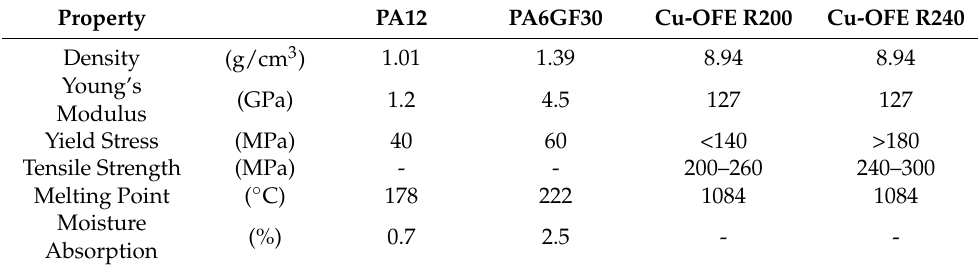
Table 1. Material properties of the investigated busbars extracted from data sheets for copper [21] and polyamide [22,23]. The properties of PA12 and PA6GF30 are given at a conditioned state (23°C and 50% relative humidity).